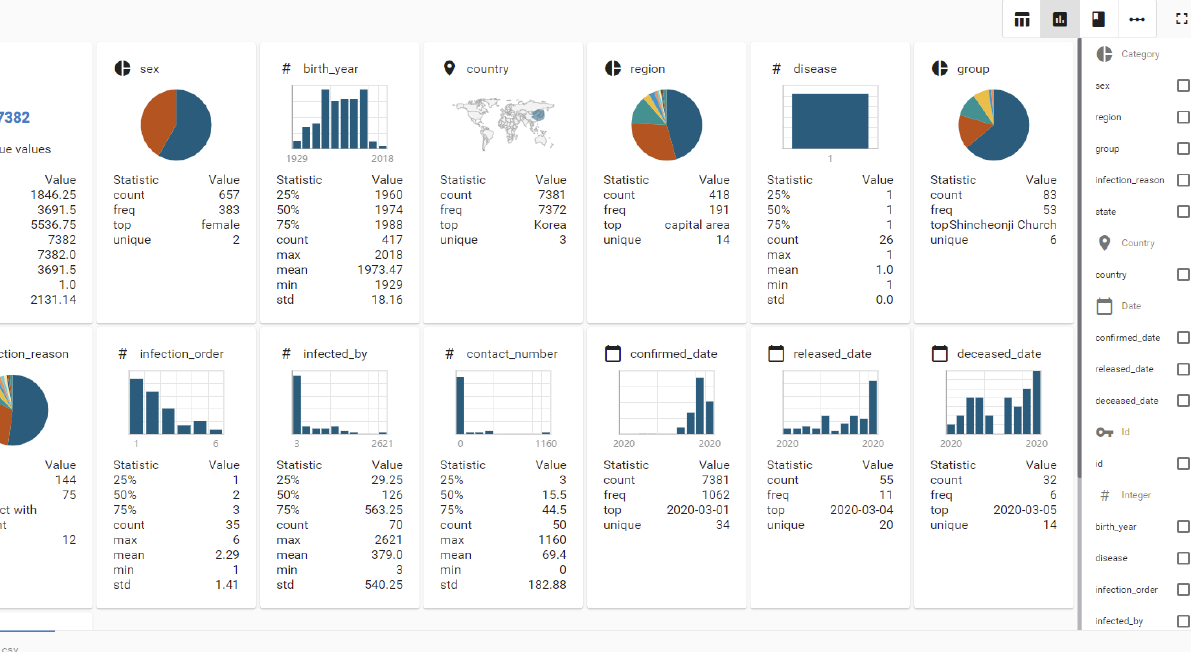
Figure 3. The initial view of the EDA tool presents an overview of all columns with the detected type and a chart suitable for visualization of the type. The right side allows selecting features for more specific